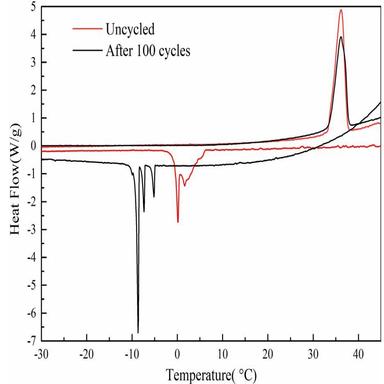
DSC curves for MPCM3 before and after 100 thermal cycles.